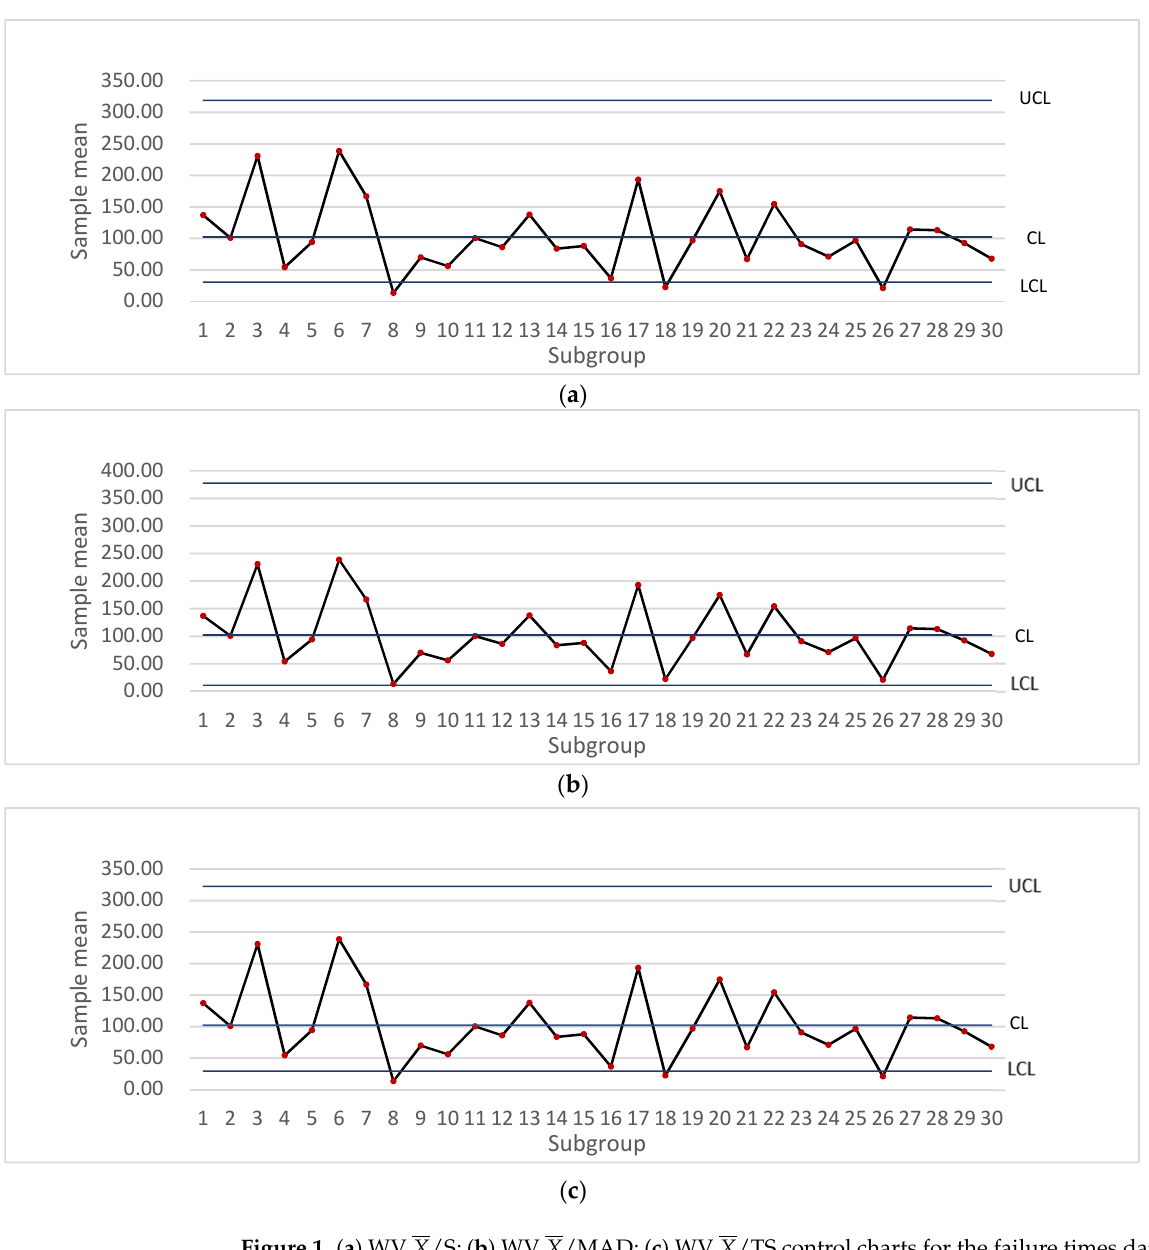
Figure 1. ( a ) WV 𝑋(cid:3364)/S ; ( b ) WV 𝑋(cid:3364)/MAD ; ( c ) WV 𝑋(cid:3364)/TS control charts for the failure times data. Figure 1. ( a ) WV X /S; ( b ) WV X /MAD; ( c ) WV X /TS control charts for the failure times